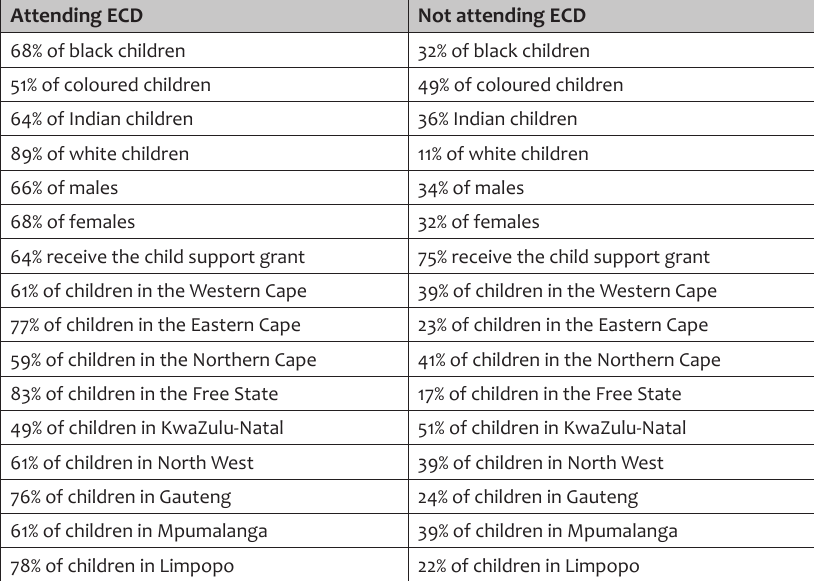
Table 1: The composition of four-year-olds (Source: SSA 2014